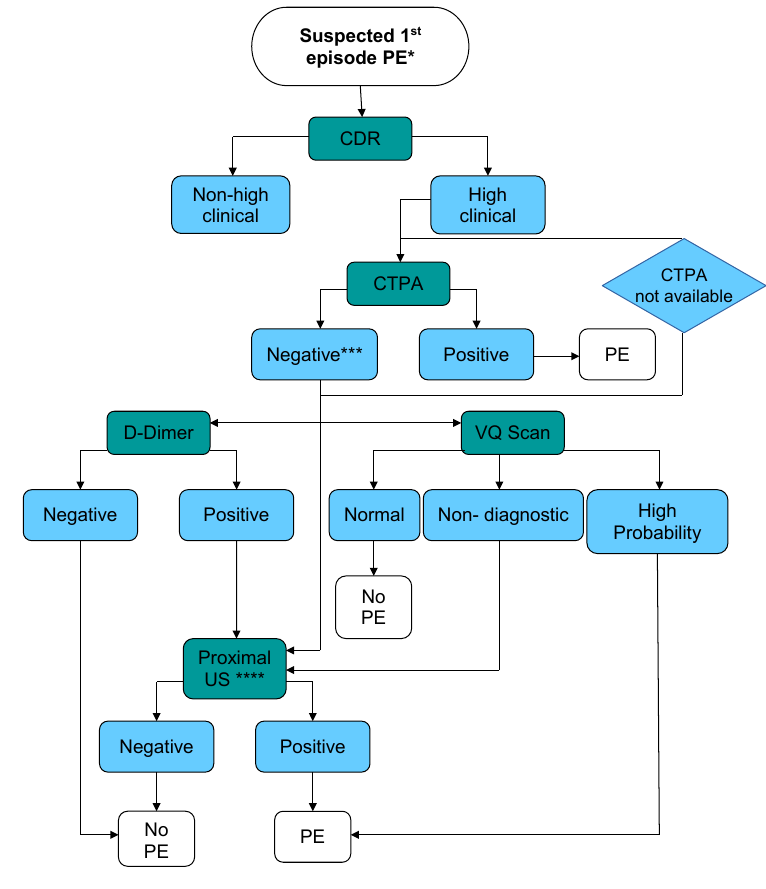
Figure 1: Algorithm for the diagnosis of PE based on a high PTP 7 *Hemodynamically stable, nonpregnant patient. **See other algorithms. ***In selected situations, negative CTPA may be enough to rule out PE. ****Serial proximal US if clinical PTP > 50%.